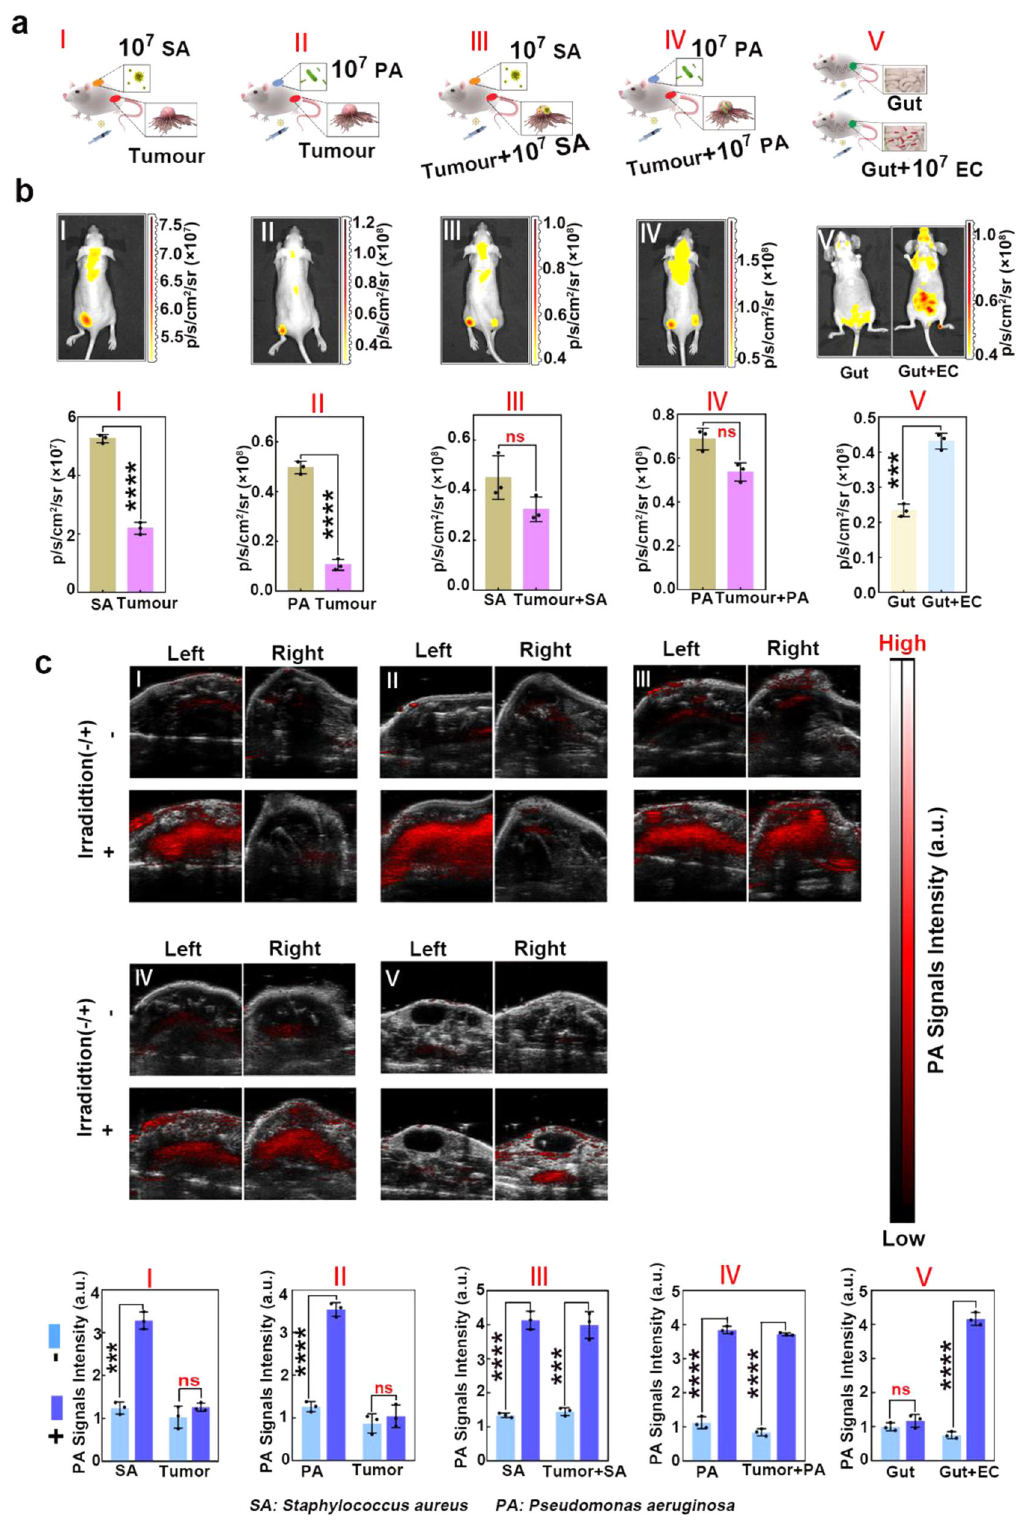
50 μ L of SA and PA are injected into the right thigh of the mice, respectively. Then, these infected mice are intravenously injected bacterial cell concentration is ~1.0 × 10 7 CFU during treatment. For systematic comparisons, these mice are then divided into six